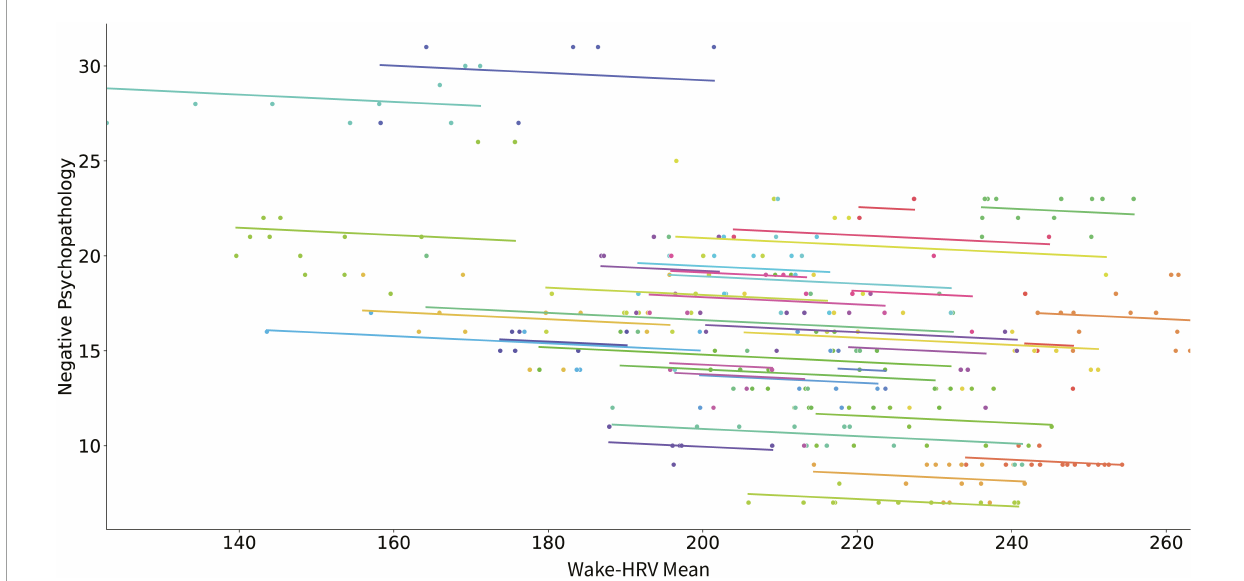
FIGURE3 Scatter plot of the relation of mean HRV during wakefulness and negative psychopathology (negative PANSS score). Each subject’s data as well as the predicted linear model line are presented with a different color.